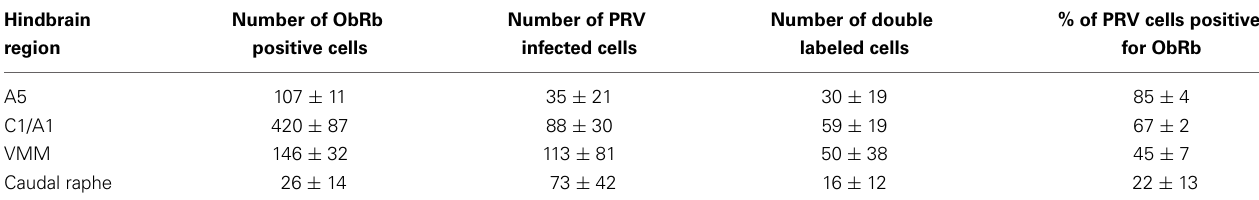
Table 1 | Distribution of leptin receptor (ObRb) expressing and psuedorabies virus (PRV) infected cells in the ventral hindbrain (mean ± s.e.m., n =